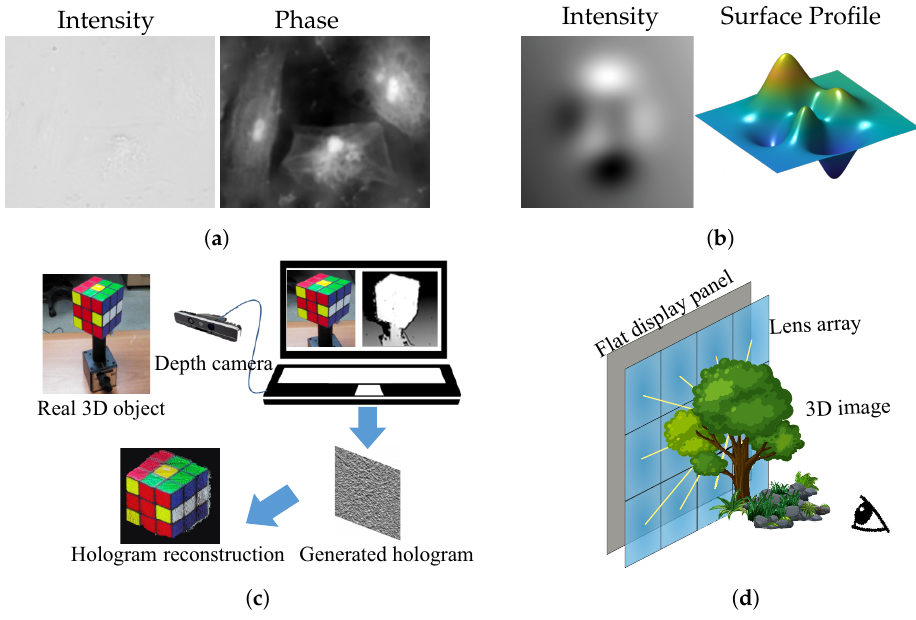
Figure 3. Applications of 3D imaging for ( a ) microscopy; ( b ) surface measurement; ( c ) holographic display; and ( d ) light field